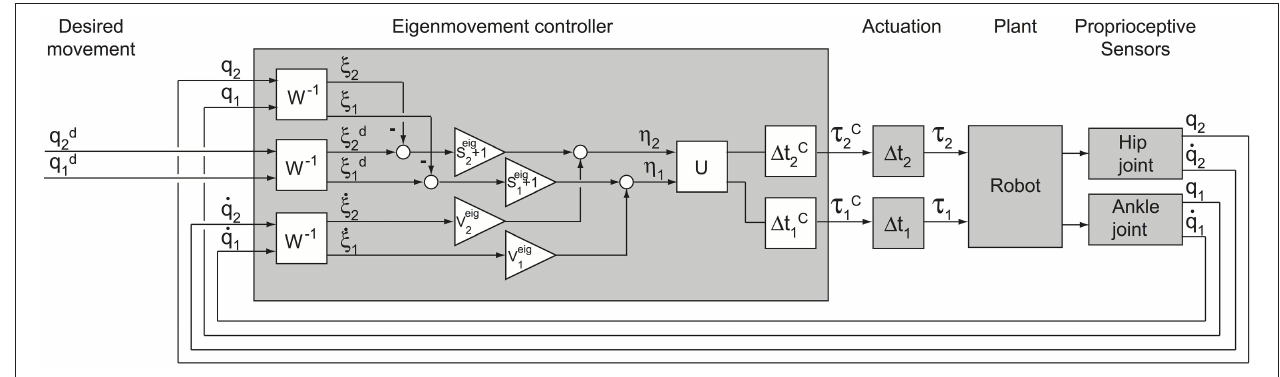
FIGURE 3 | Scheme of EM control. Shown are the EM controller, the actuation, the plant and the sensors. The PD-controller transforms desired and sensory variables q into EM kinematic variables ξ (boxes W − 1 ) and then into EM dynamic variables η con (boxes S eig + 1 and V eig ) which are in turn transformed into output joint torques τ C (box U) with controller time delays (boxes ∆ t C ). Torque τ C becomes effective at the robot segment after an actuation time delay (boxes 1 t). Note, that in boxes S eig + 1 the unit is added to S eig in order to take into account the first “gravity” term in the right side of Equation (7). Matrices S eig , V eig , W and U are defined above.